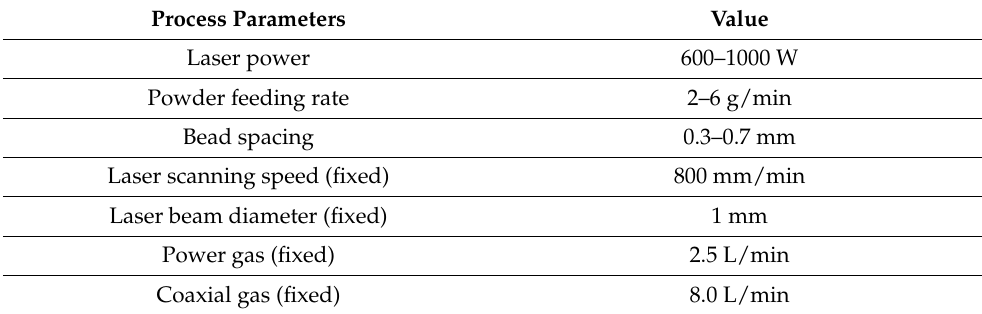
Table 2. Process parameters of the powder-fed DED.